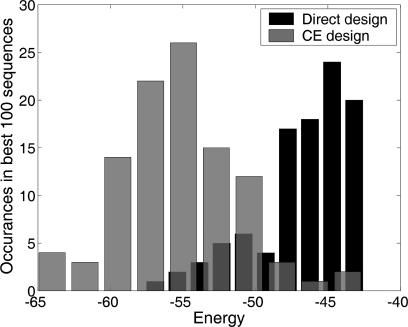
Distribution of the Energies of the Top 100 Sequences from Direct Design and CE DesignThe best solutions from CE design were modeled and repacked using the direct method for comparison purposes. Thus, the reported energy is that computed using the direct method for both cases. The best sequence found with CE design is significantly better than the best one from direct design. Also, the ensemble of best sequences found with CE is significantly more stable than that from direct design. This indicates that its greater speed allows CE design to reach and sample a lower-energy sequence space.